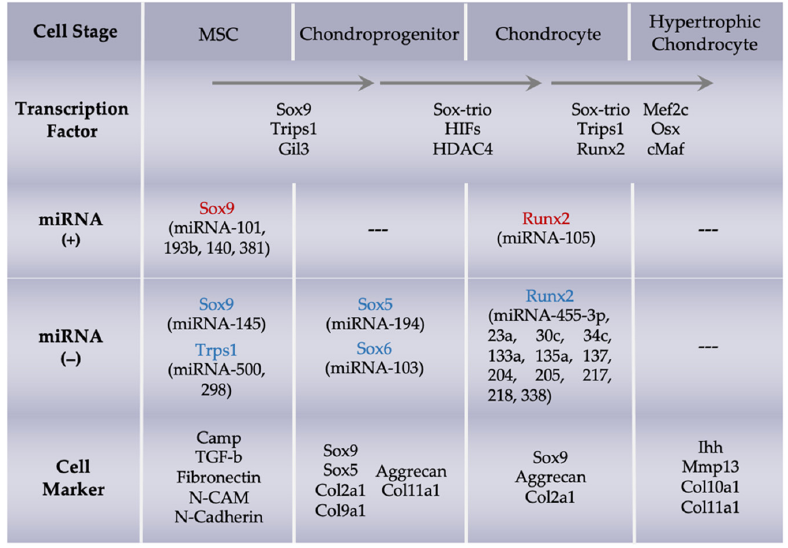
Figure 3. Schematic illustrating transcription factors and miRNA regulators involved in chondro- cyte differentiation of adipose-derived stem cells (ADSCs). Abbreviations: sex-determining region Y–related high-mobility group box 9 (SOX9); trichorhinophalangeal syndrome type 1 (TRPS1); runt-related transcription factor 2 (RUNX2); hypoxia inducible factor (HIF); histone deacetylase 4 (HDAC4); myocyte enhancer factor 2c (MEF2c); osterix (Osx); C-musculoaponeurotic fibrosarcoma (cMaf); cathelicidin antimicrobial peptide (CAMP); transforming growth factor beta (TGF- β ); neural cell adhesion molecule (N-CAM); type II procollagen (Col2a1); type IX collagen alpha 1 chain (Col9a1); type XI collagen (Col11a1); Indian hedgehog (Ihh); matrix metalloproteinase 13 (MMP13); type X collagen (Col10a1). Table 2. MicroRNAs involved in cartilage